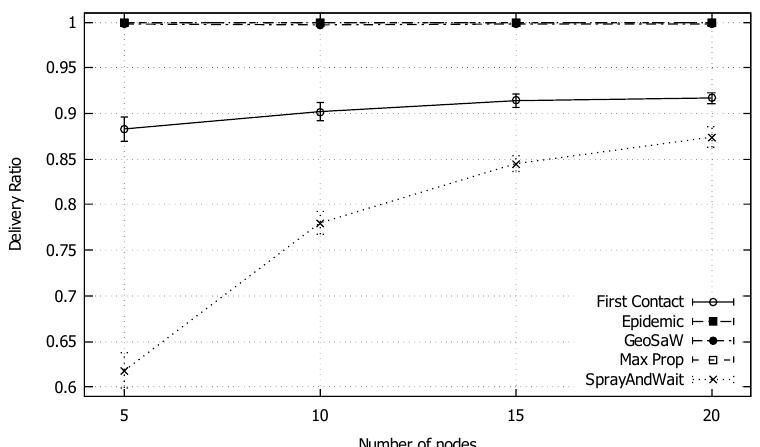
Figure 4. Average delivery ratio of GeoSaW compared with other DTN routing protocols when varying the number of nodes.